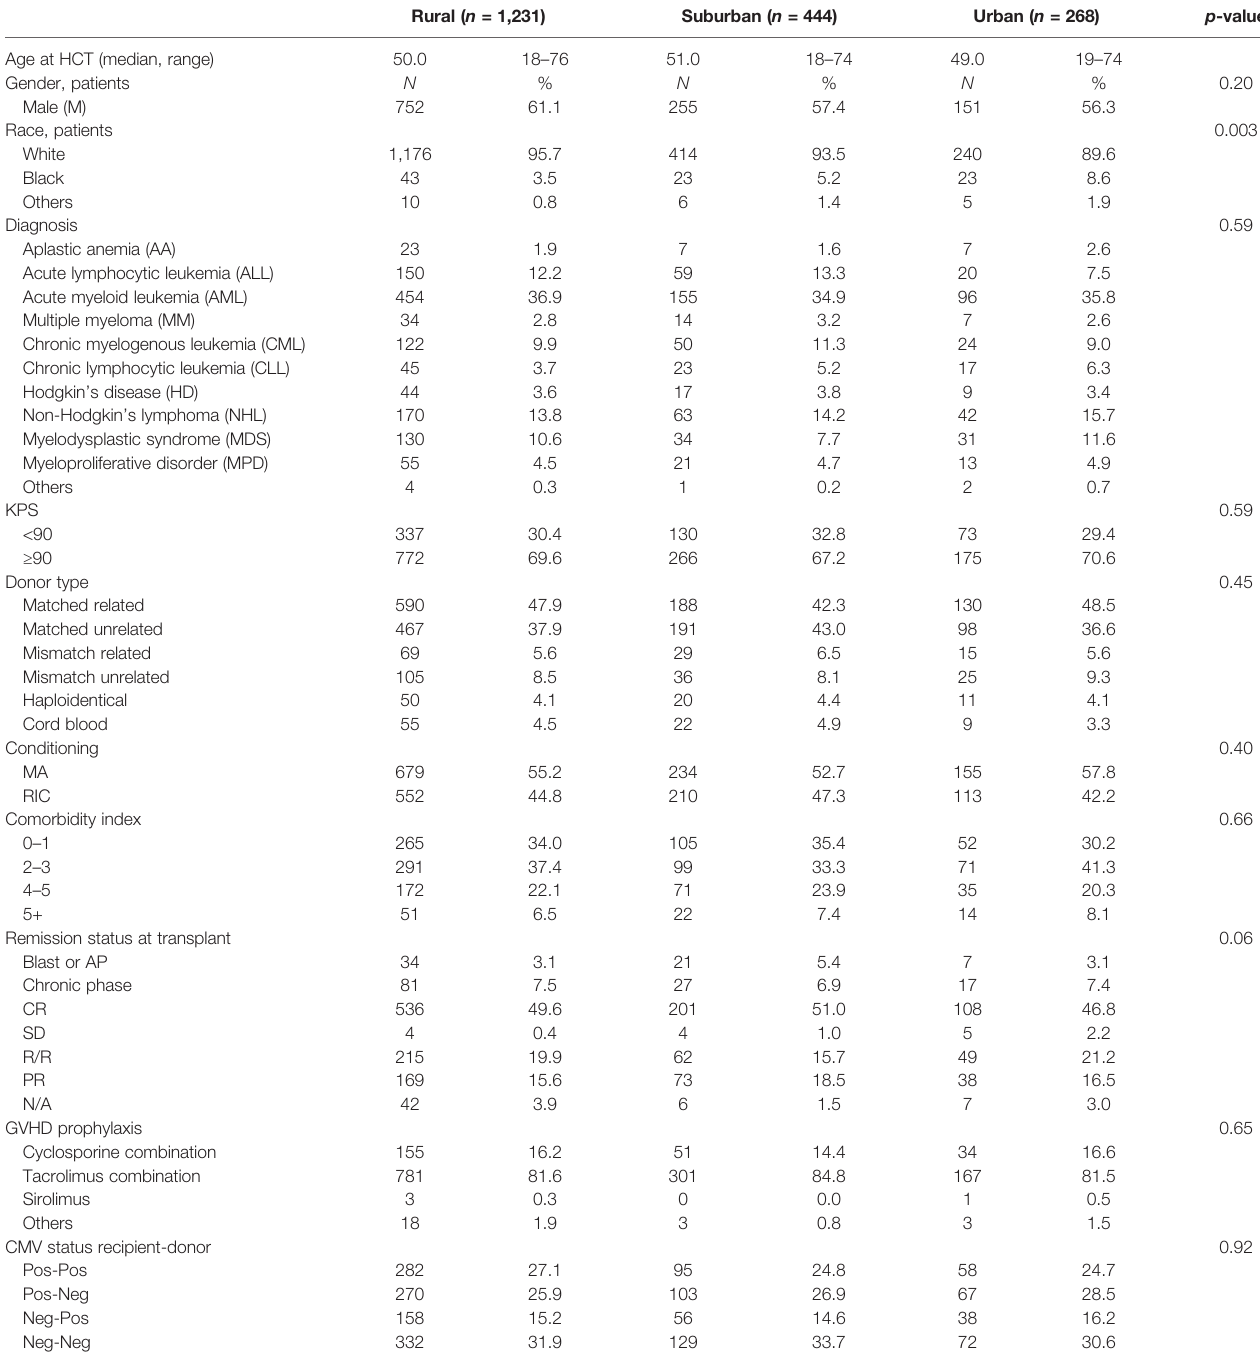
TABLE 2 | Patient characteristics by location. Rural ( n = 1,231) Suburban ( n = 444) Urban ( n = 268) p -value Age at HCT (median,